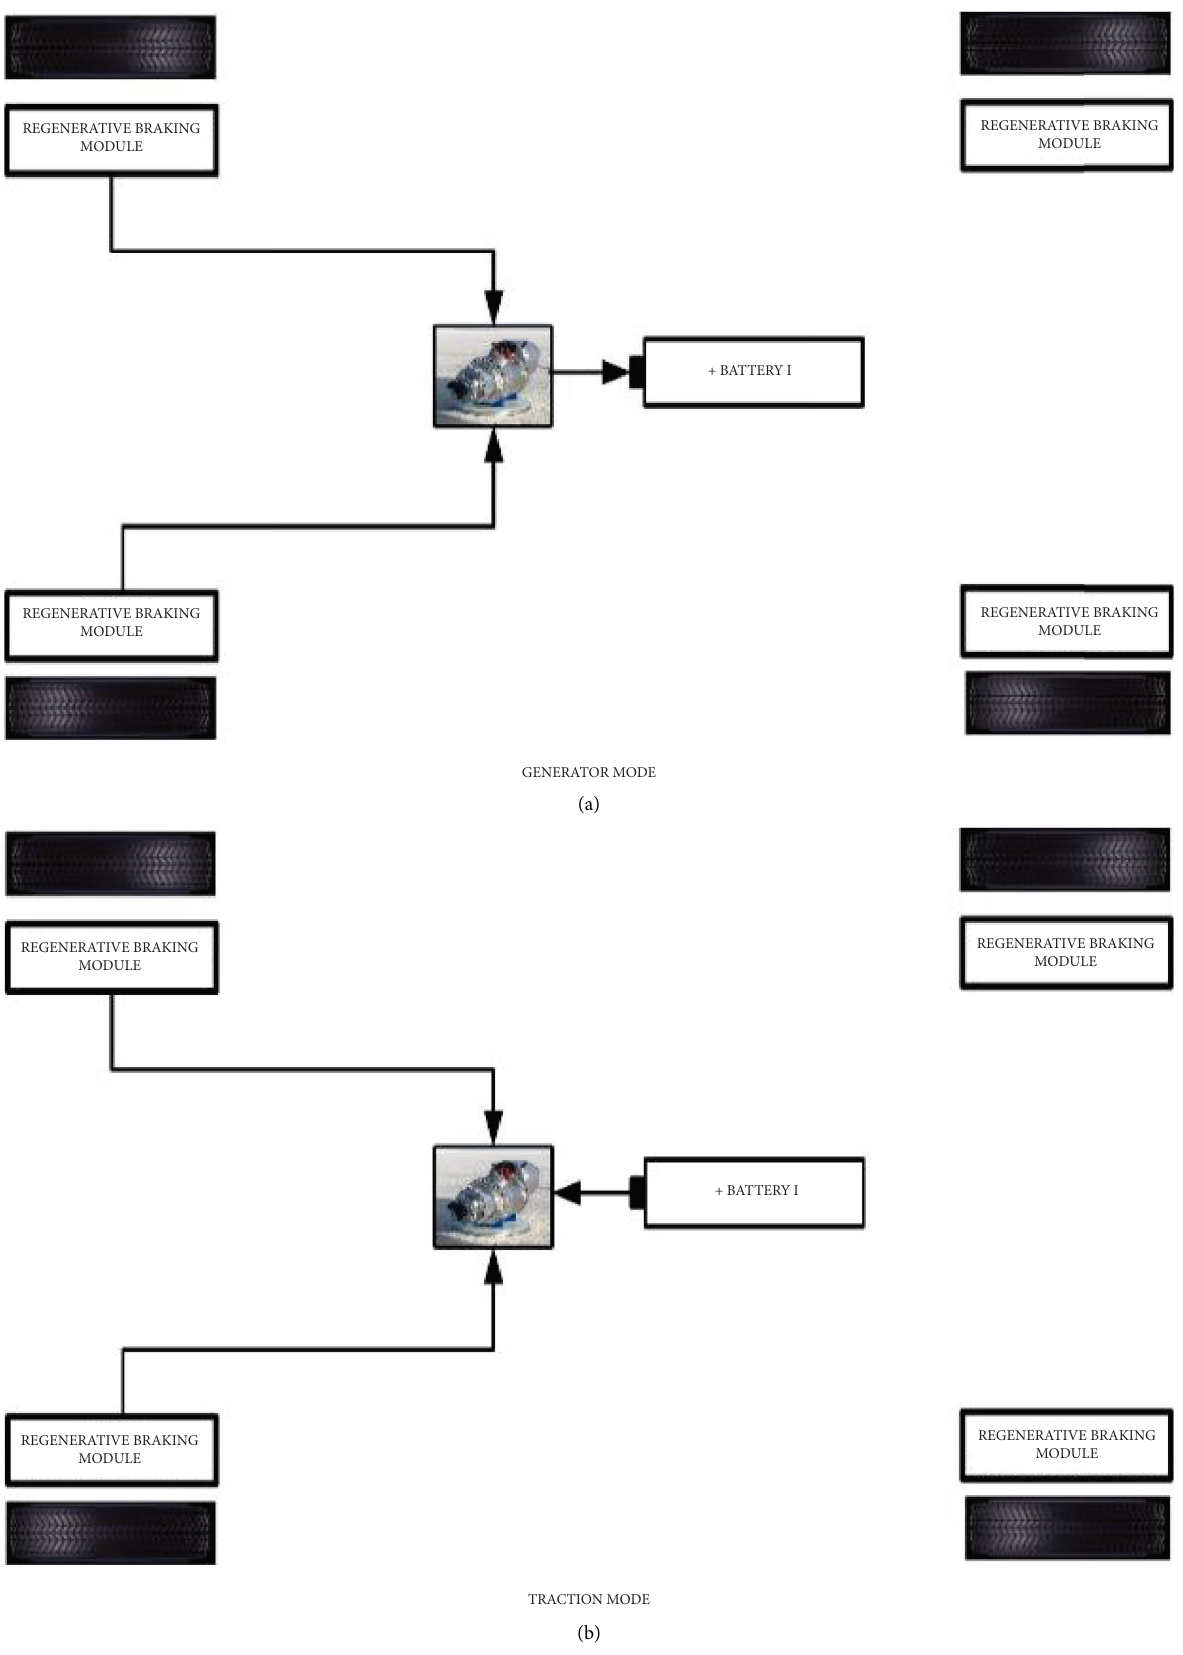
Figure 6: Te energy fow in ER-RB confguration: (a) generator mode; (b) traction